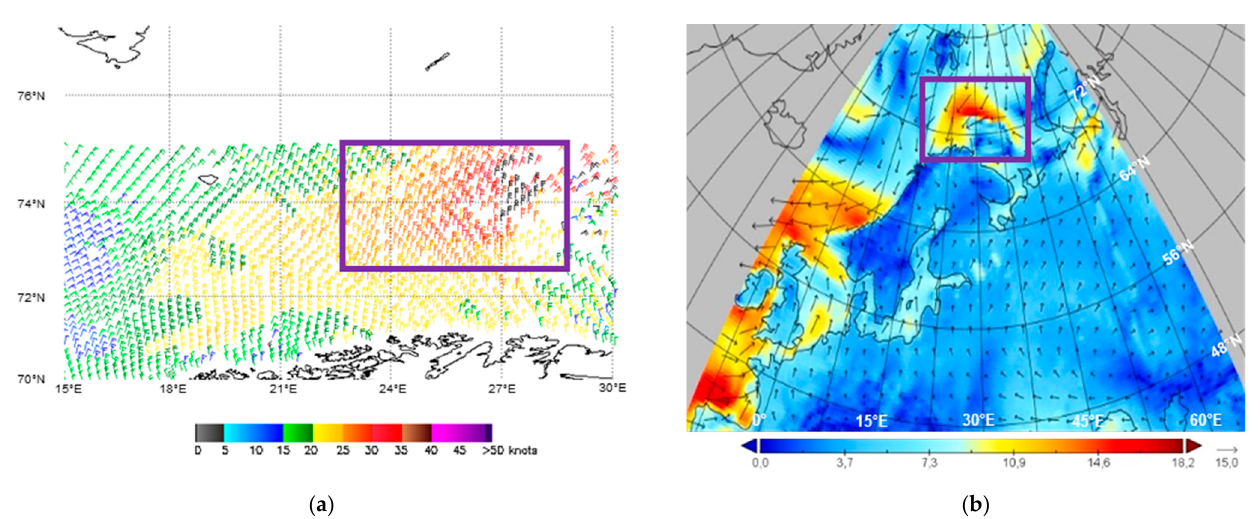
Figure A1. Surface wind speed according to the ASCAT scatterometer ( a ) and ERA5 reanalysis ( b ). 18:00 UTC 26 November 2019.